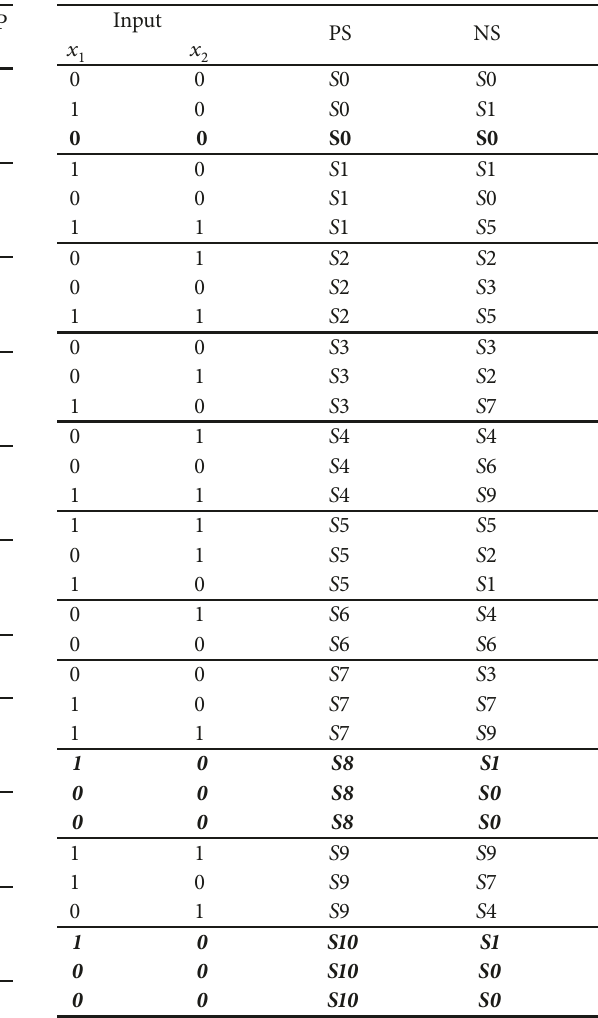
Table 3: Updated description of 𝑡𝑟𝑎𝑖𝑛11 . Table 4: Updated description of 𝑙𝑖𝑜𝑛9